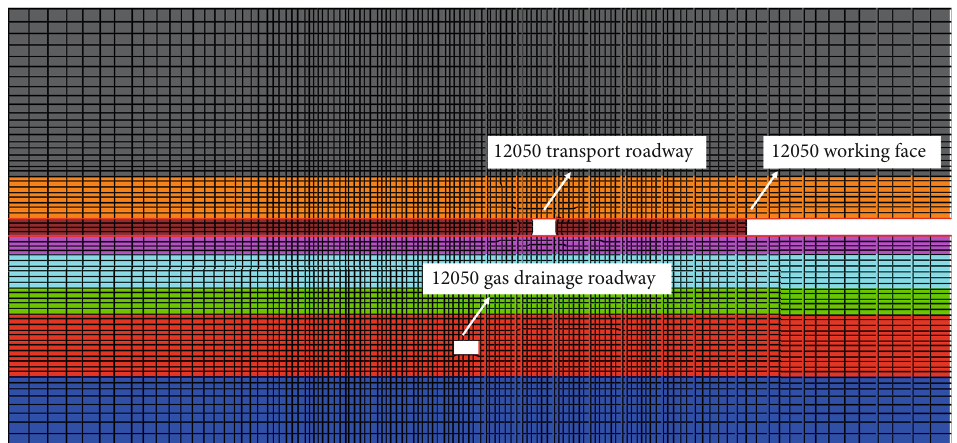
Figure 9: Numerical simulation model of staggered arrangement.